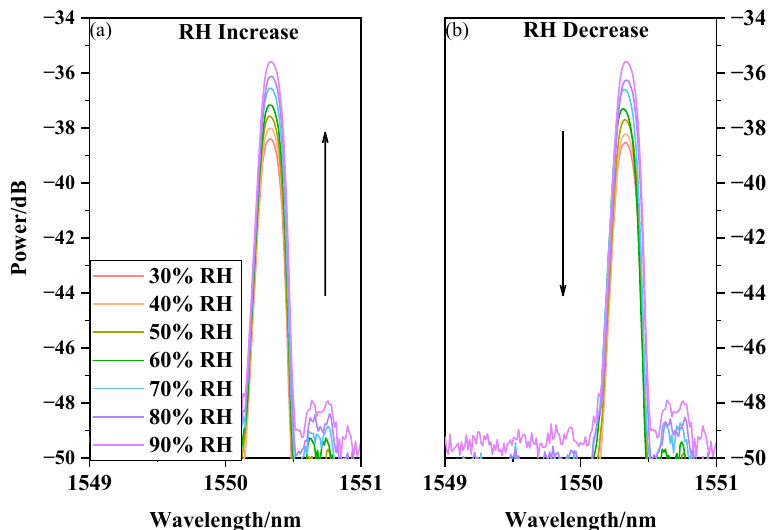
Figure 10. PVA/CNTs composite nanofiber film humidity response with RH increase and decrease. ( a ) RH Increase; ( b ) RH Decrease.